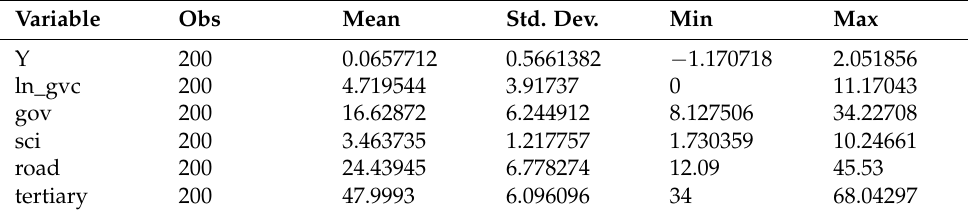
Table 7. Variable descriptive statistics.